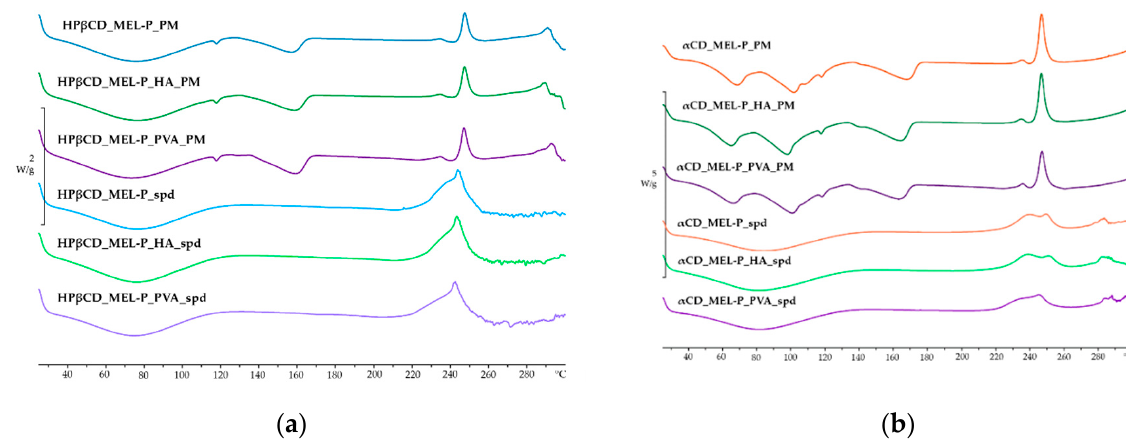
Figure 4. DSC curves of: ( a ) the HP β CD-containing and ( b ) the α CD-containing PMs and spray dried samples .